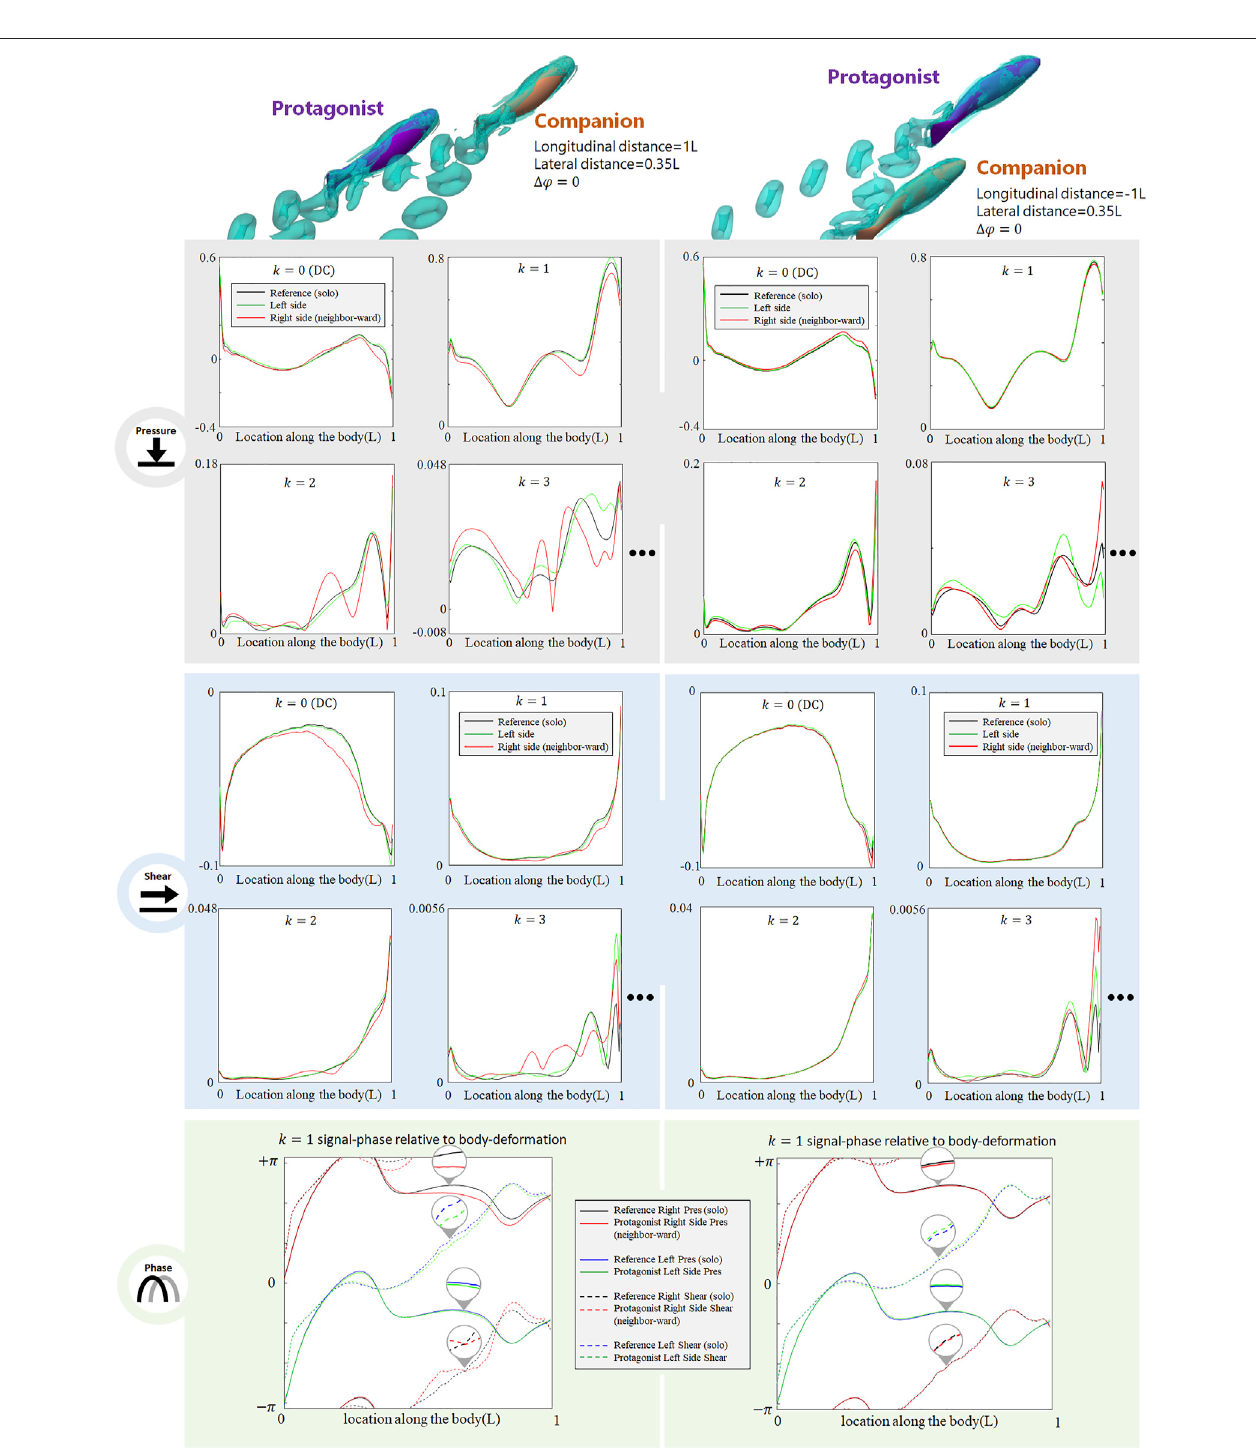
FIGURE 6 | Signal features sensed by the protagonist fi sh when an in-phase neighbor is in diagonal front position (LHS), and diagonal rear position (RHS). Full results are presented in Supplementary Figures S8,S9 , ESM. One stress unit = 10 Pa.